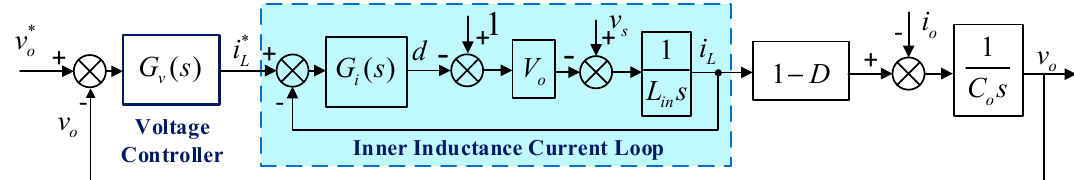
Figure 3. Basic structure of dc/dc converter dual loop controller.